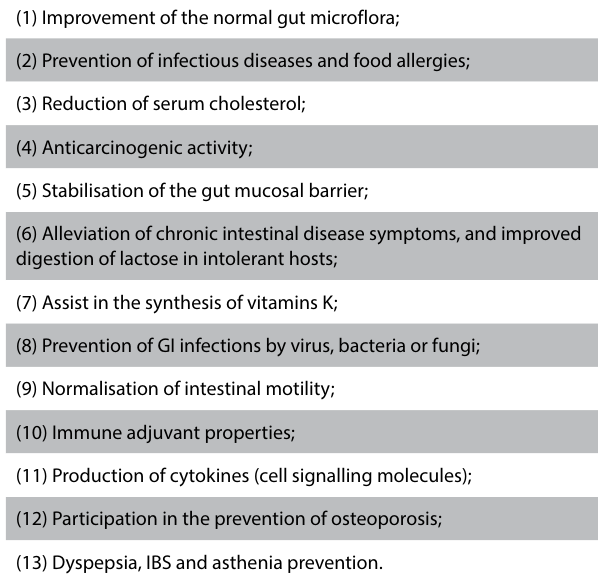
Table 3. Probiotics’ therapeutic or health